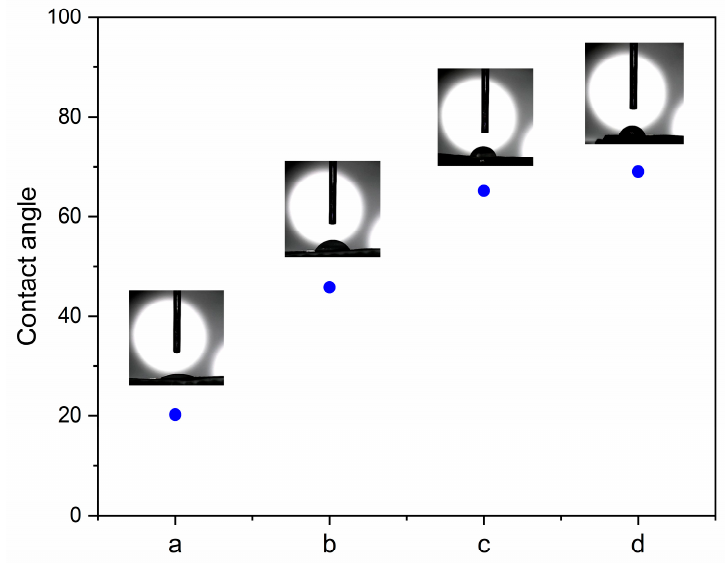
Figure 8. Contact angle of ( a ) M0.50/P30-DPNR, ( b ) M0.50/P30-DPNR/Si10, ( c ) M0.50/P30-